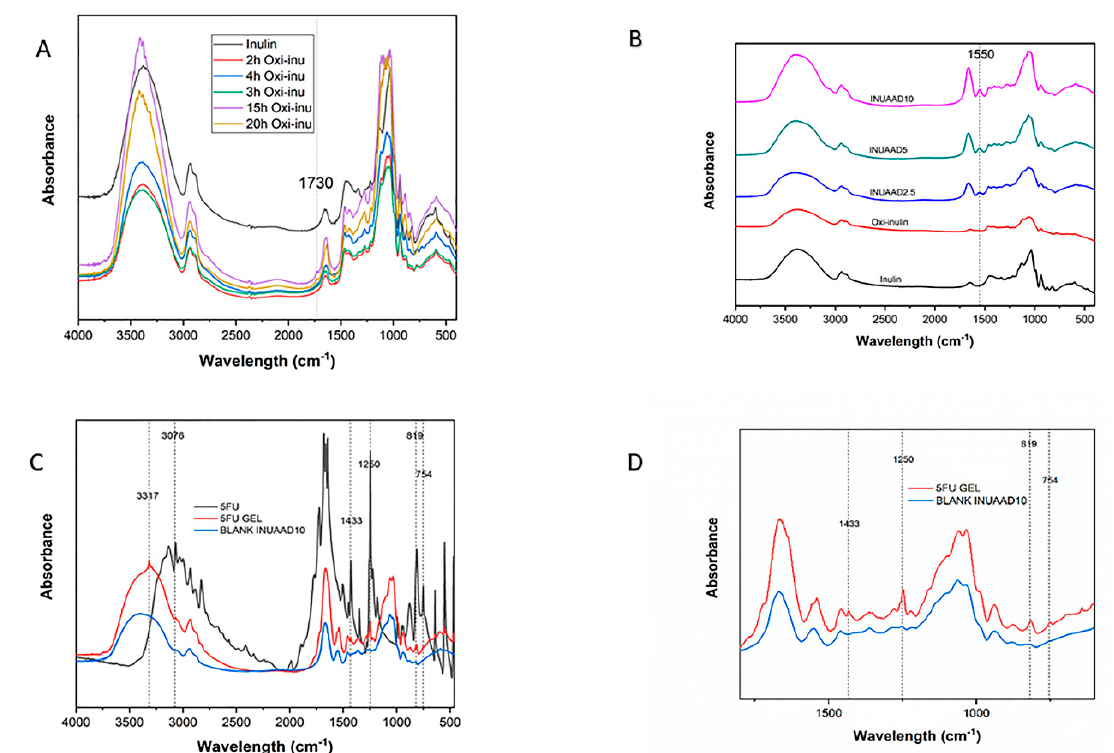
Figure 2. ( A ) The spectra of all the oxi-inulin and raw inulin samples. ( B ) The spectra of inulin, oxidized inulin (oxi-inulin), and the hydrogels. ( C ) Spectra of pure 5-fluorouracil (5FU), blank INUAAD10 gel, and 5FU-loaded hydrogel. ( D ) spectra of blank INUAAD10 and 5FU-loaded INUAAD10 hydrogel .